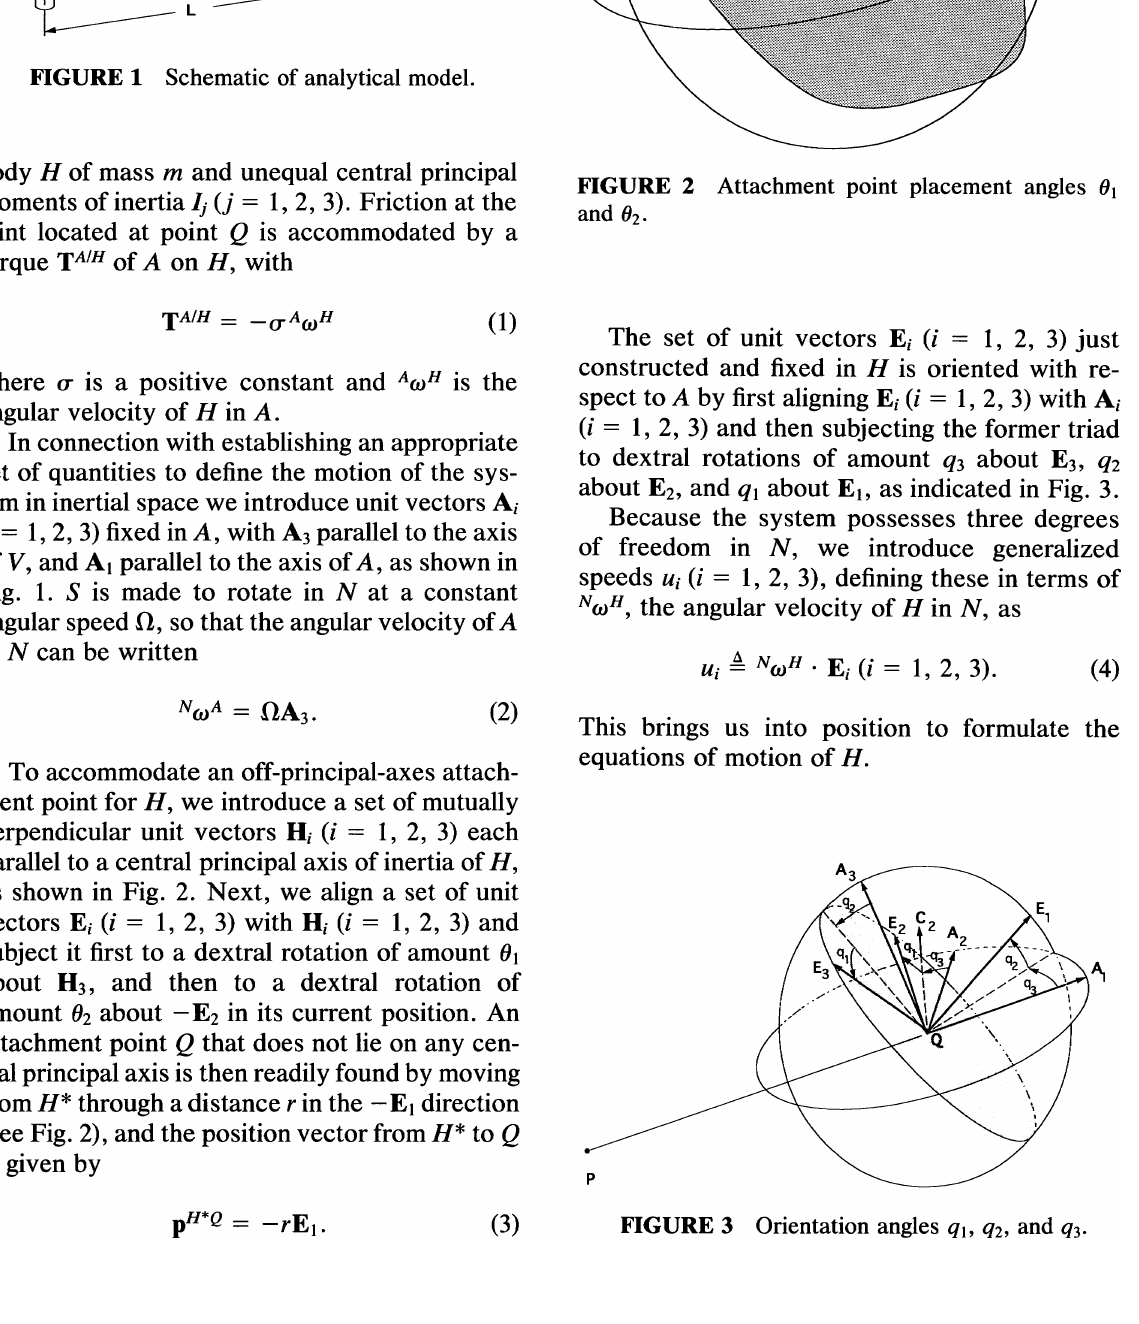
FIGURE 1 Schematic of analytical model.